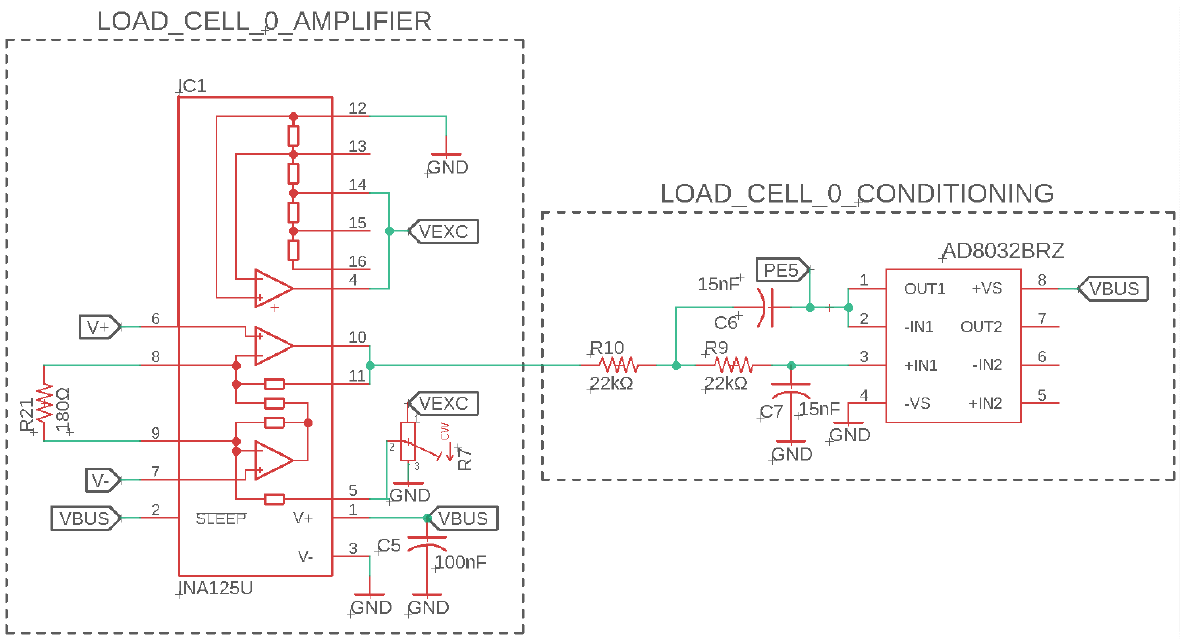
Figure 4. The INA125 instrumentation amplifier was utilized with a second order low − pass Sallen − Key filter to collect linear load cell force feedback with a Wheatstone bridge